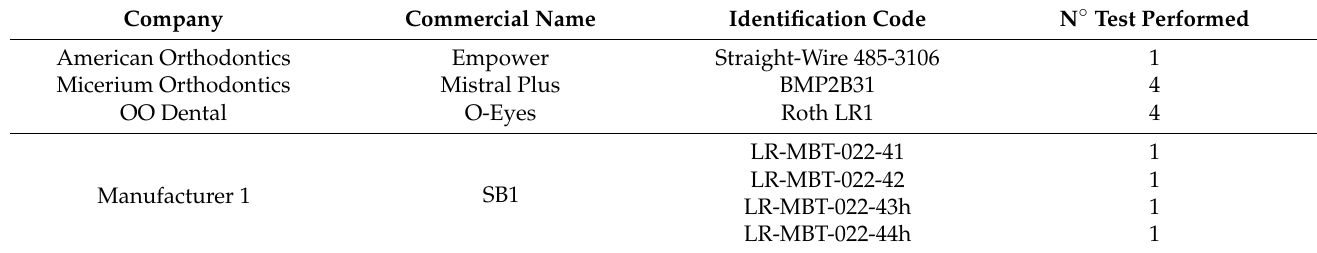
Table 2. Self-ligating brackets tested.